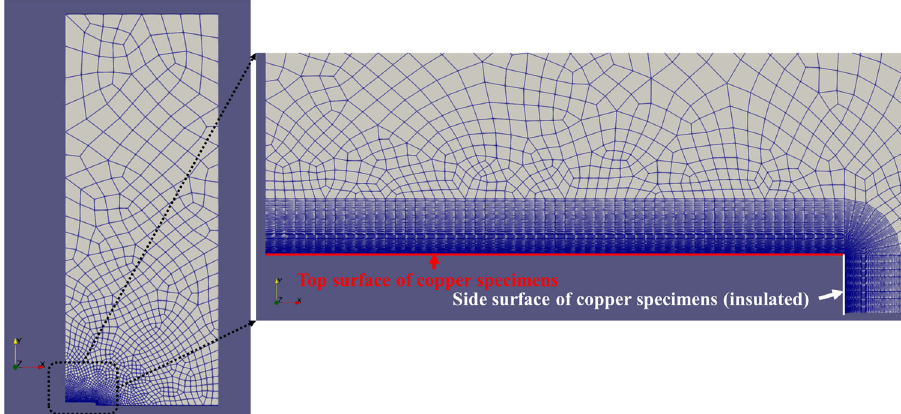
Fig. 3 Geometry for simulated corrosion of Cu. Simpli fi ed 2-D geometry for simulating corrosion of Cu immersed in 1 L of solution containing both HS − and Cl − ions.